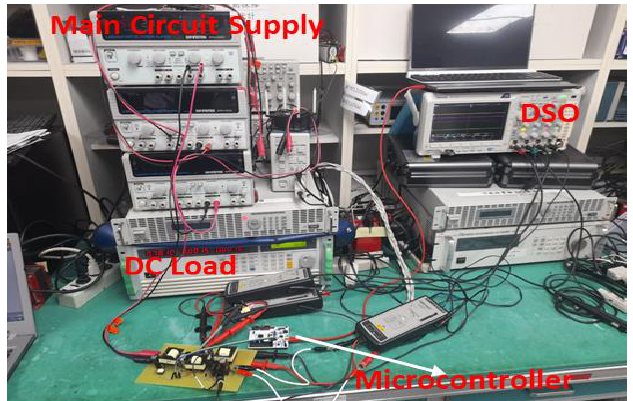
Figure 14. Hardware testing setup .